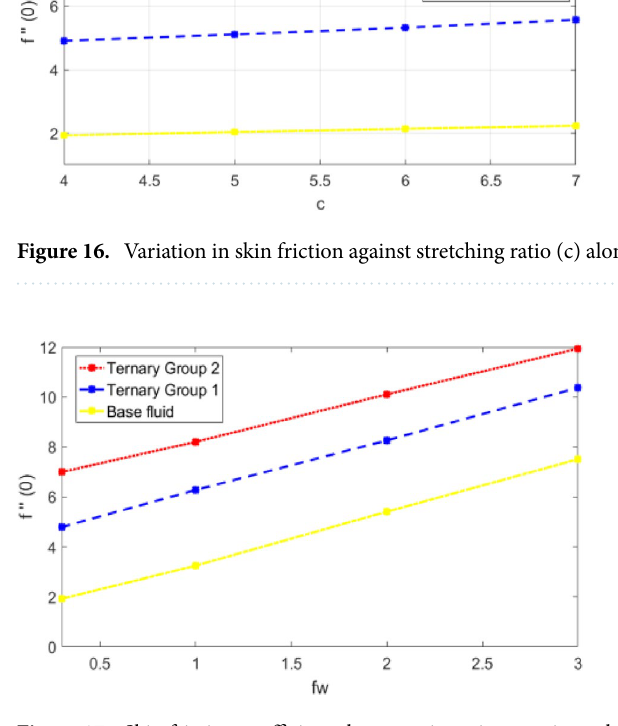
Figure 17. Skin friction coefficient along x-axis against suction velocity